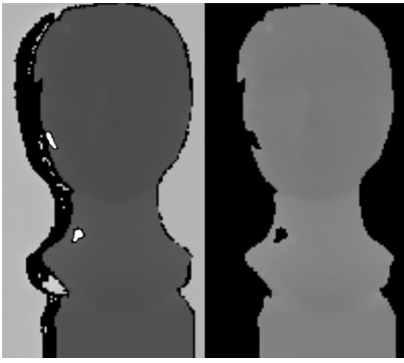
Figure 8. Input depth image with interference. The left image with extreme interference regions before depth thresholding. The right image without extreme interference regions after depth